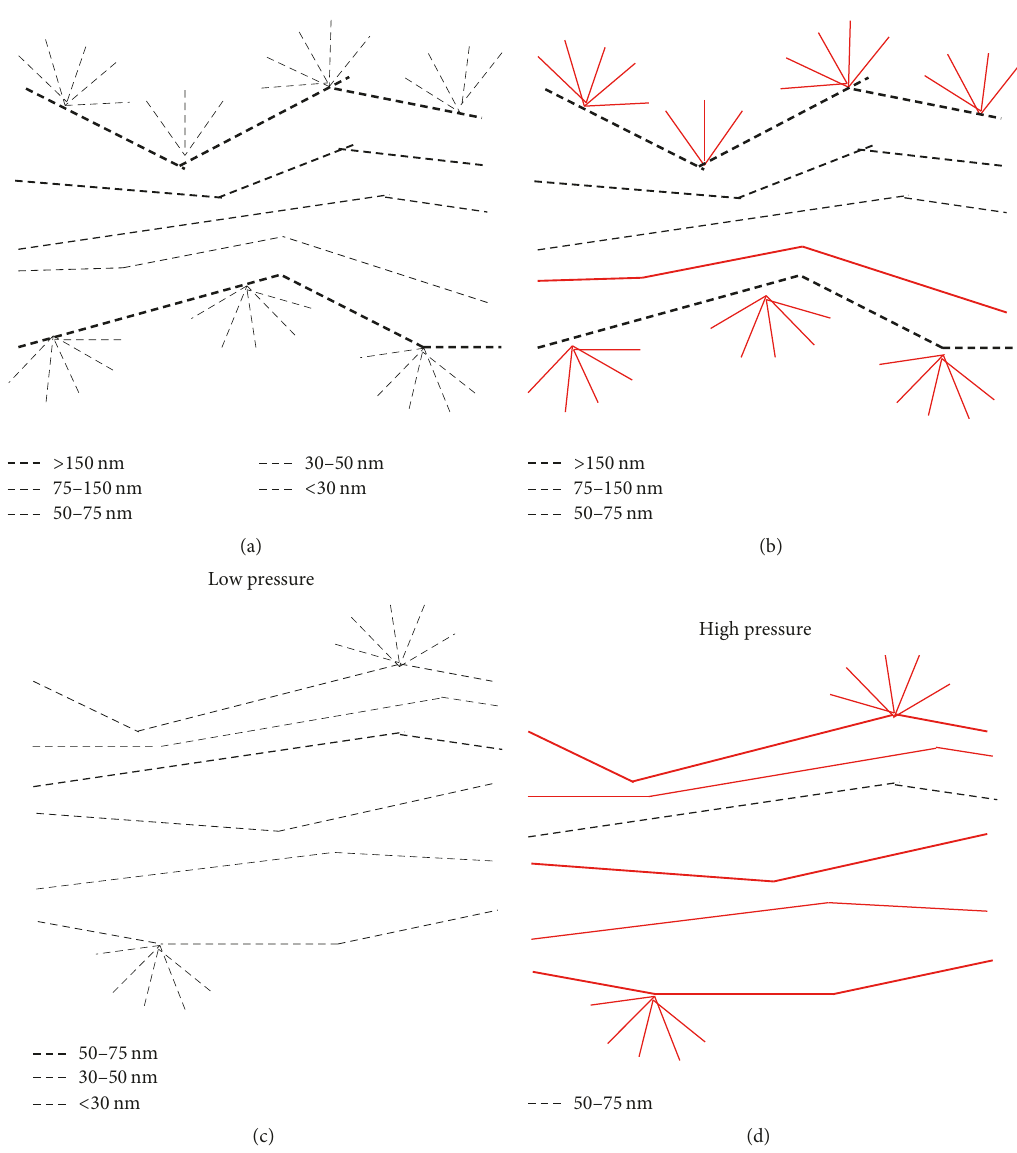
Figure 12: Acyclic pore network model for a pore structure where the pores most responsible for limiting fluid flow are in the macropore range ((a) and (b)) and mesopore range ((c) and (d)). Solid red lines indicate pores filled with liquid/semiliquid ethane. Ethane capillary condensation at high pore pressures completely blocks off the highest flow capacity flow paths in the mesoporous pore network (d) but has a limited impact on flow capacity in the macroporous pore network (b). Pore network models are modified from Sakhaee-Pour and Bryant,